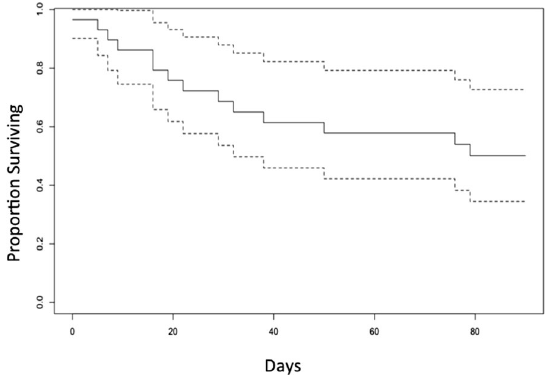
Fig. 1 probability of survival after ICU